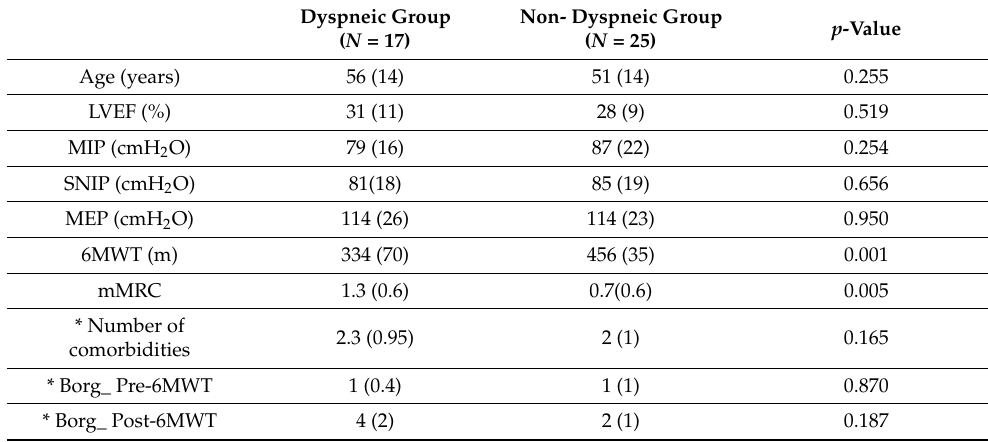
Table 2. Clinical and physiological characteristics of dyspneic and non-dyspneic groups. Dyspneic Group ( N =